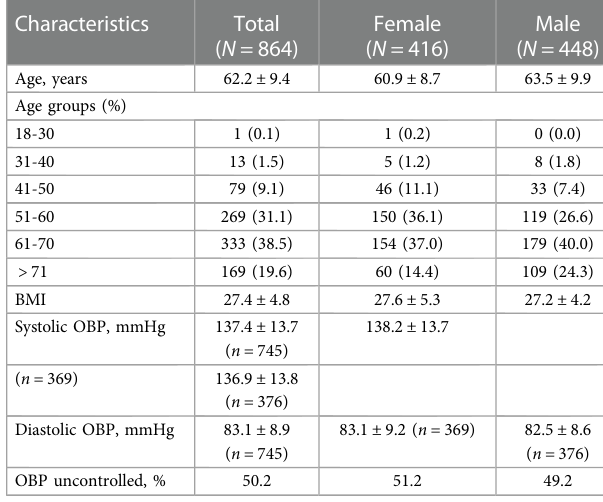
TABLE 3 Baseline characteristics of users with complete follow-up data (8-16 weeks).